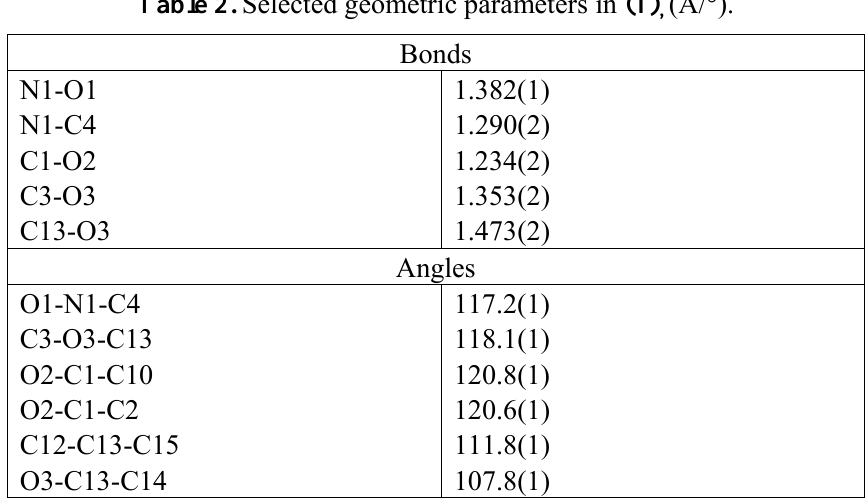
Table 2. Selected geometric parameters in (1)